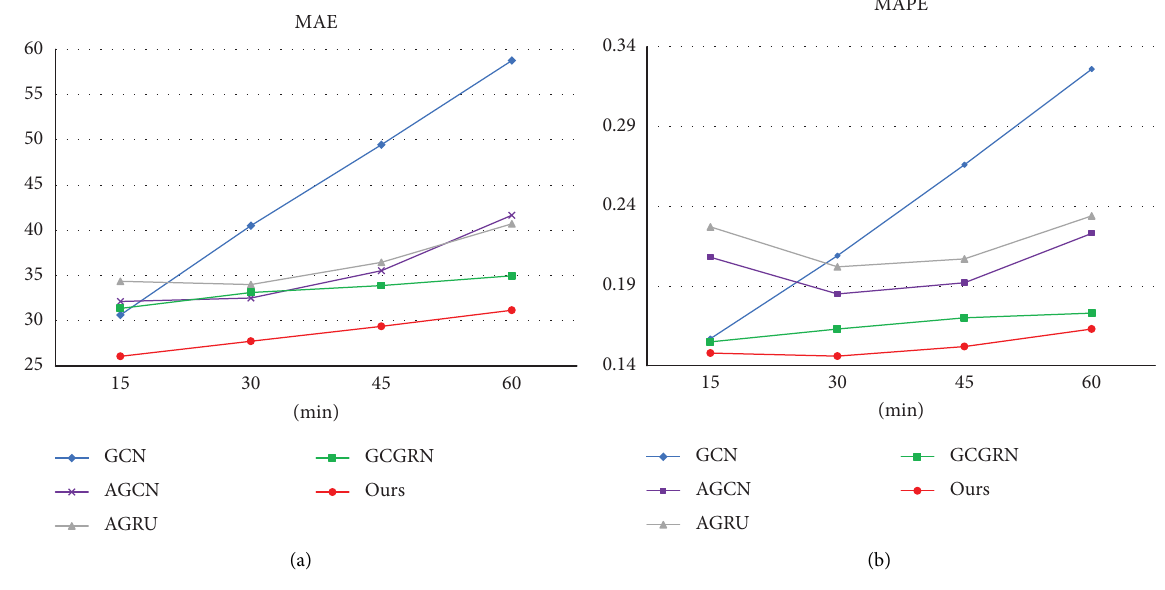
Figure 8: Ablation experiments performed on the HW-ENG dataset.